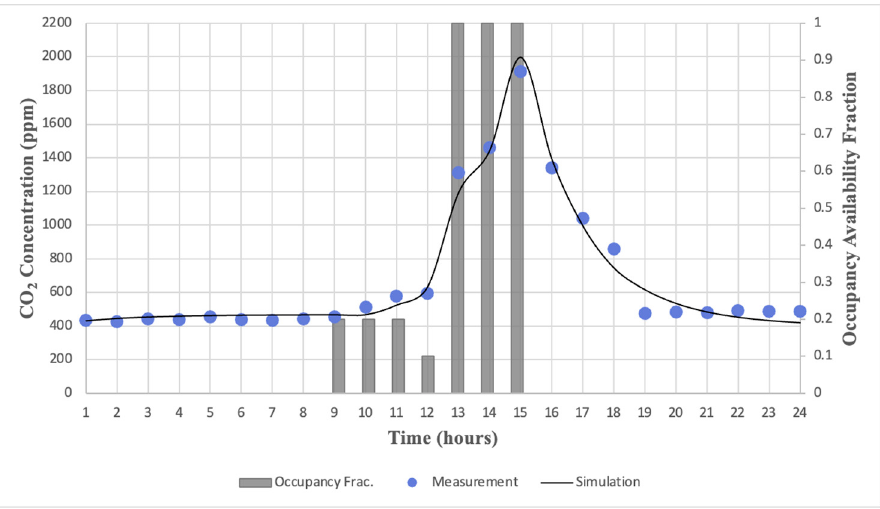
Figure 4. Validation of the time variation in the indoor CO 2 concentration for the analyzed school.